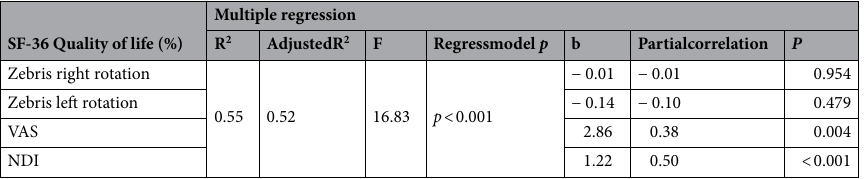
Table 6. Assessment of physical dimension quality of life relative to range of rotation, pain intensity and disability level (Zebris / VAS / NDI). R 2 , regression model; Adjusted R 2 , regression model, removes extreme values; F, Fisher’s test result; b, regression coefficient; partial correlation, the variable Xi is correlated with the variable Y after accounting for effects of all the remaining independent variables (simultaneous effect of all the four factors); p , significance level.